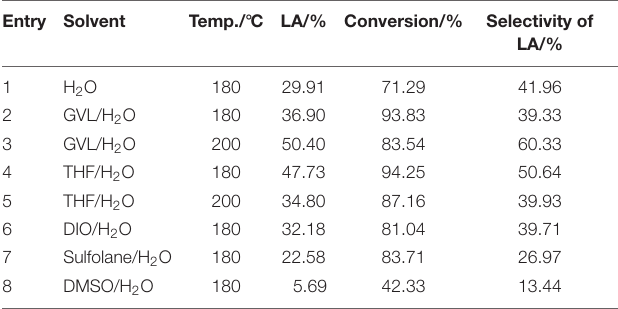
TABLE 2 | Effect of different biphasic solvent systems on cellulose conversion and LA yield a